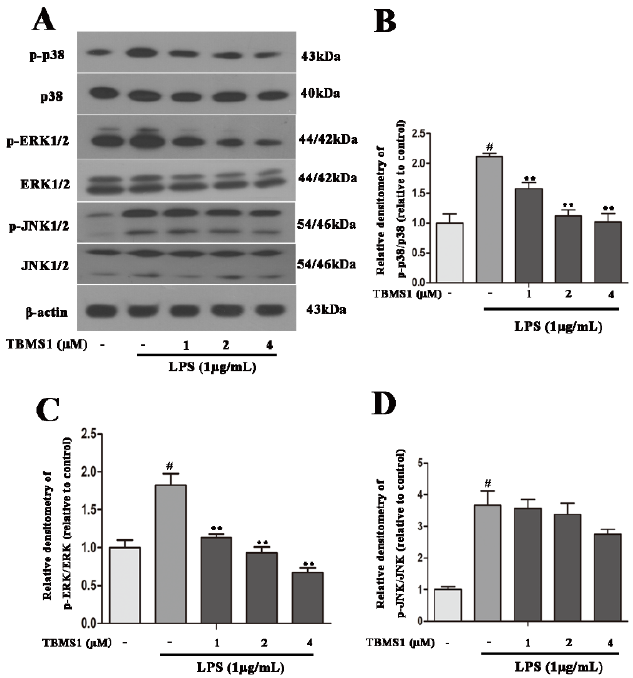
Figure 8. TBMS1 inhibits the phosphorylation of p38 and ERK1/2 in LPS-exposed BV-2 cells. The BV-2 cells were pretreated for 1 h with TBMS1 (1, 2 and 4 µ M), then incubated with LPS (1 µ g/mL) for 1 h. ( A ) The protein levels of p38, ERK1/2, JNK1/2 and their phosphorylated forms were tested by western blotting. The phosphorylation of p38 ( B ), ERK1/2 ( C ) and JNK1/2 ( D ) was analyzed relative to β -actin. The results are shown as mean ± SD of three independent experiments. # p < 0.01 versus control condition. ** p < 0.01 versus the TBMS1-untreated LPS-exposed cells, and statistical significance was determined by ANOVA.